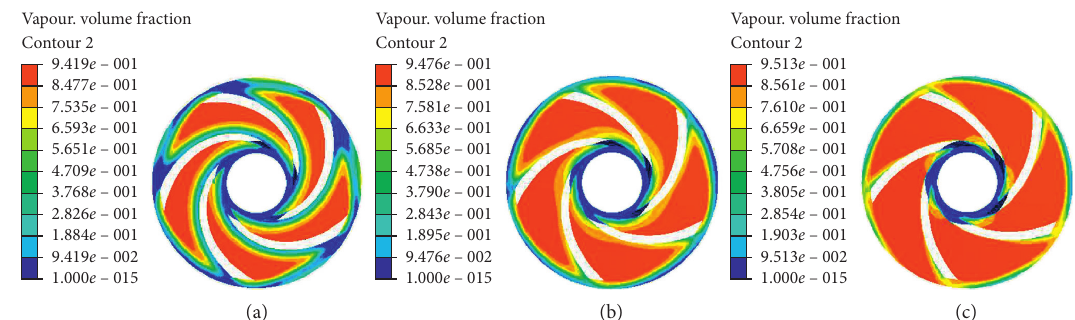
Figure 14: Gas volume fraction chart with different outlet angles. (a) β